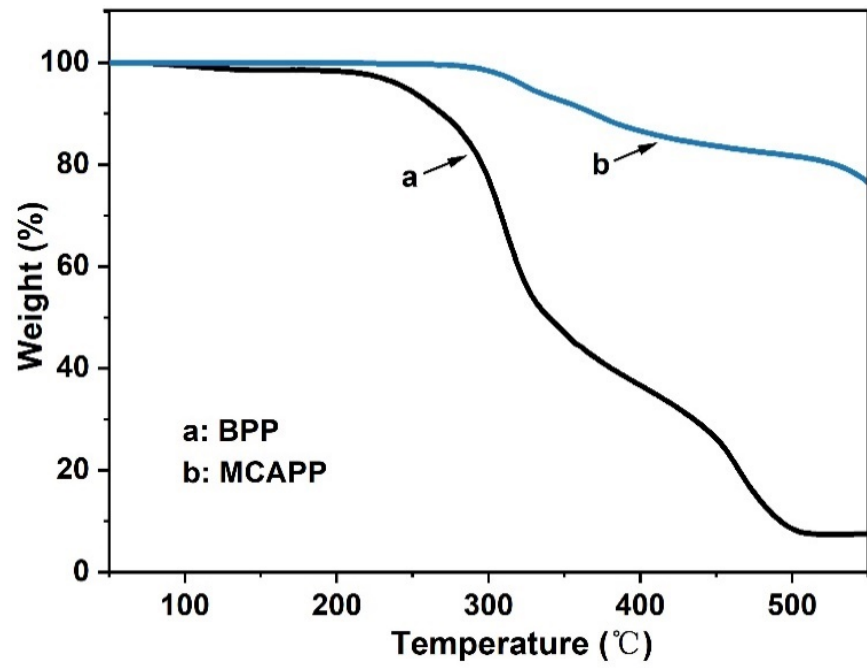
Figure 4. The thermogravimetric analysis (TG) curves of MCAPP and BPP.